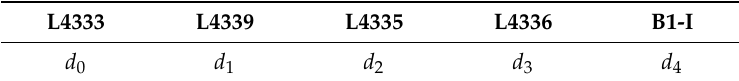
Table 2. The Encoding of the Component.